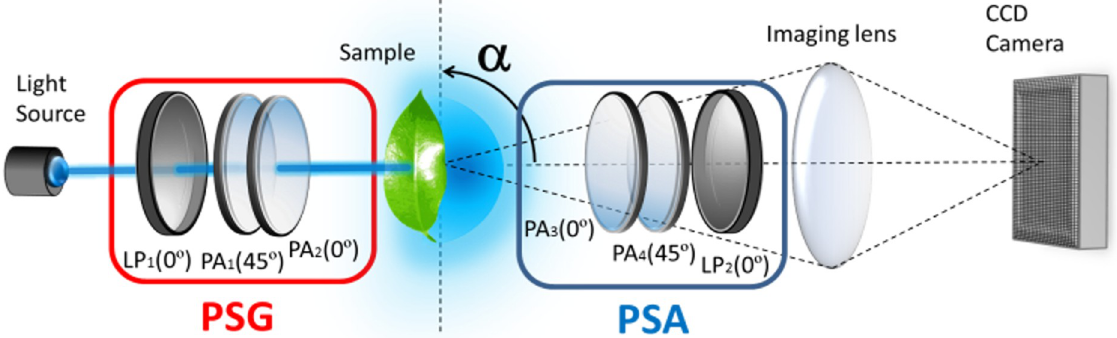
Fig 2. Scheme of the imaging polarimeter used to measure the Mueller matrices of plant